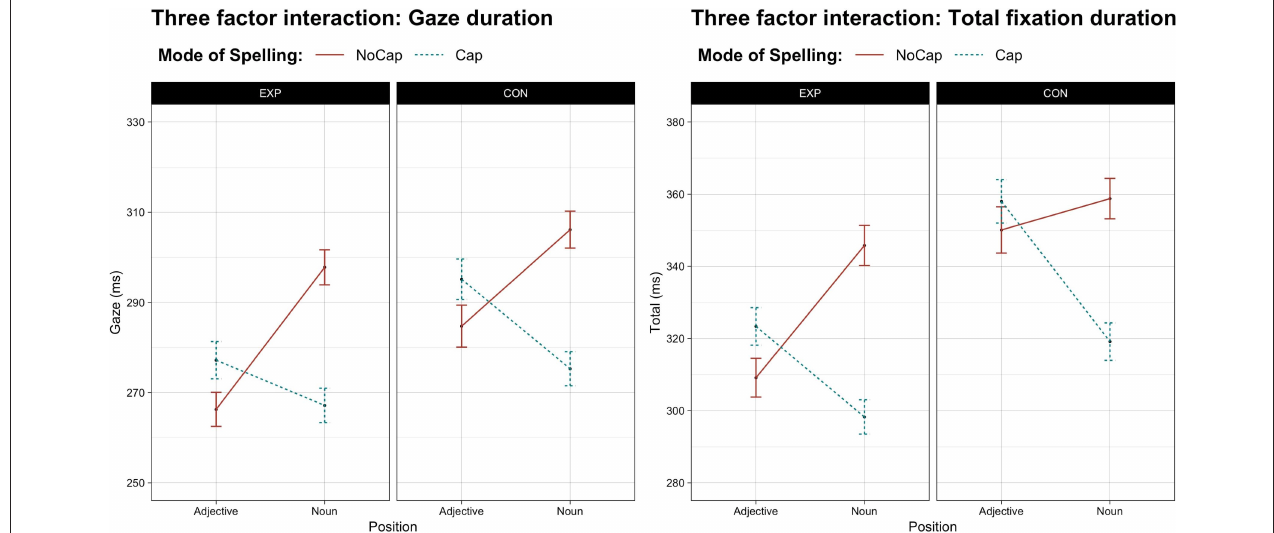
FIGURE 3 | Estimated values of the three-way interactions of SPELLING (Cap vs. NoCap), SENTENCEMODE (EXP vs. CON) and POSITION (Adjective vs. Noun) (cf. Table 2 ) in Gaze duration (to the left) and in the Total fixation duration (to the right); error bars represent the standard errors. The garden-path sentences (EXP, garden-path only in NoCap) are shown to the left and the control sentences (CON) are represented to the right. The blue (dotted) lines represent sentences that follow German standard orthography; the red (solid) lines represent sentences in which the nouns are not capitalized.